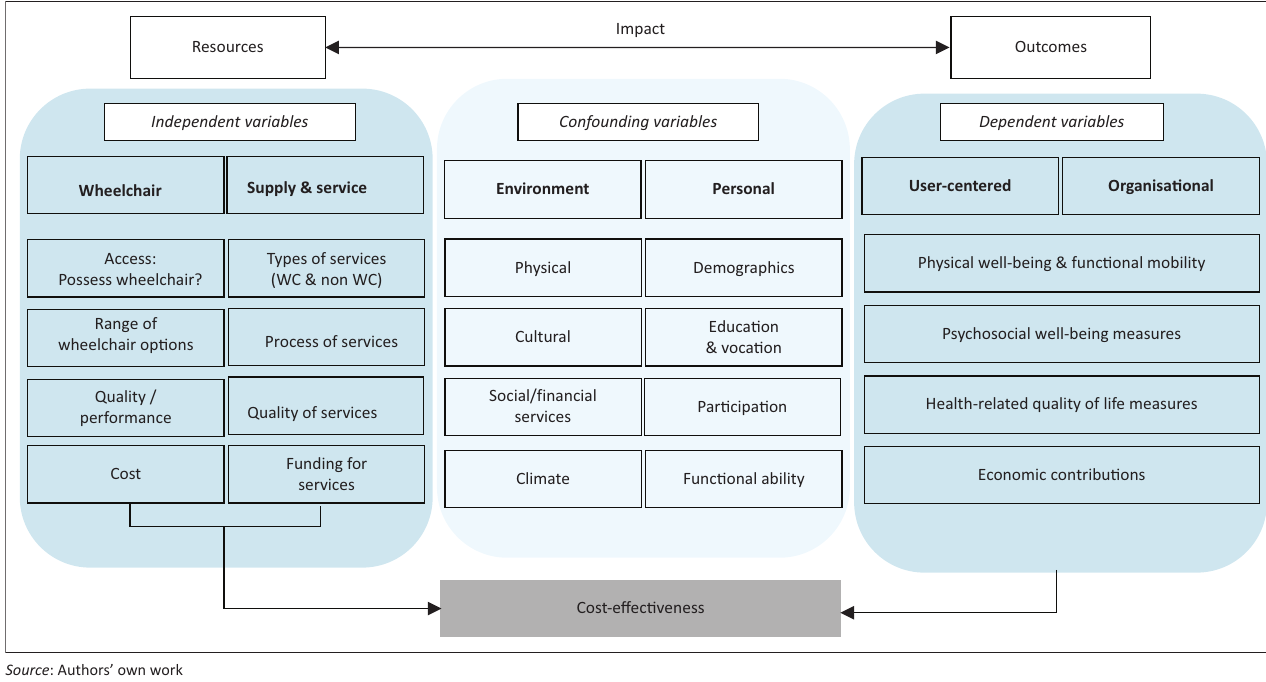
FIGURE 2: Conceptual framework illustrating the factors that affect wheelchair